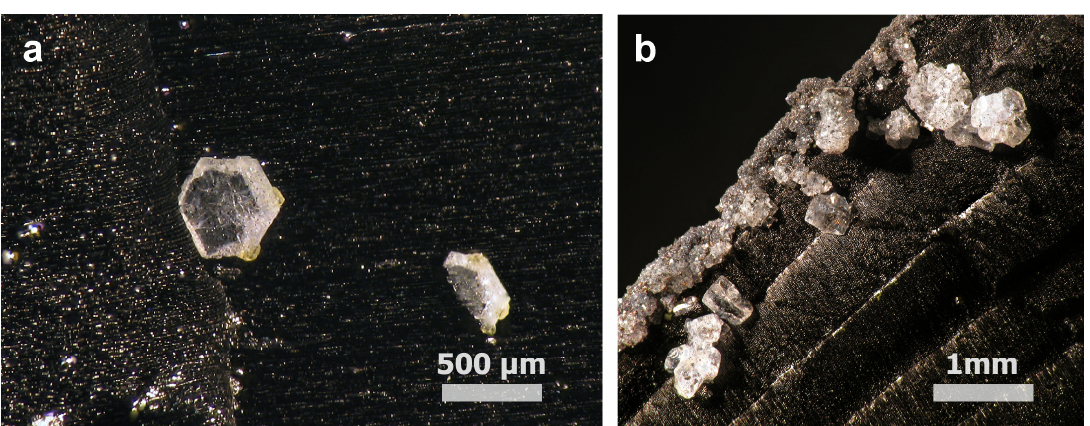
Table 1. Crystal data and structure refinement for dmisteinbergite.